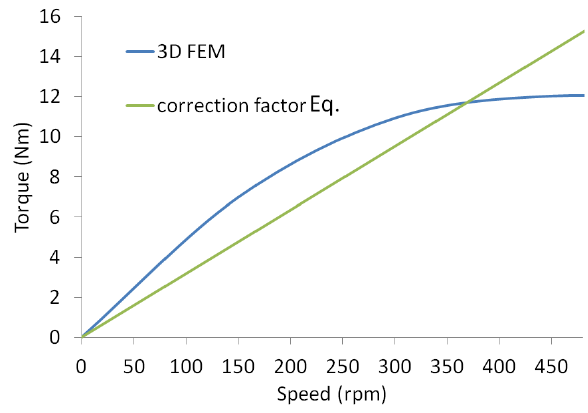
Figure 5. Low-speed correction factor braking torque.